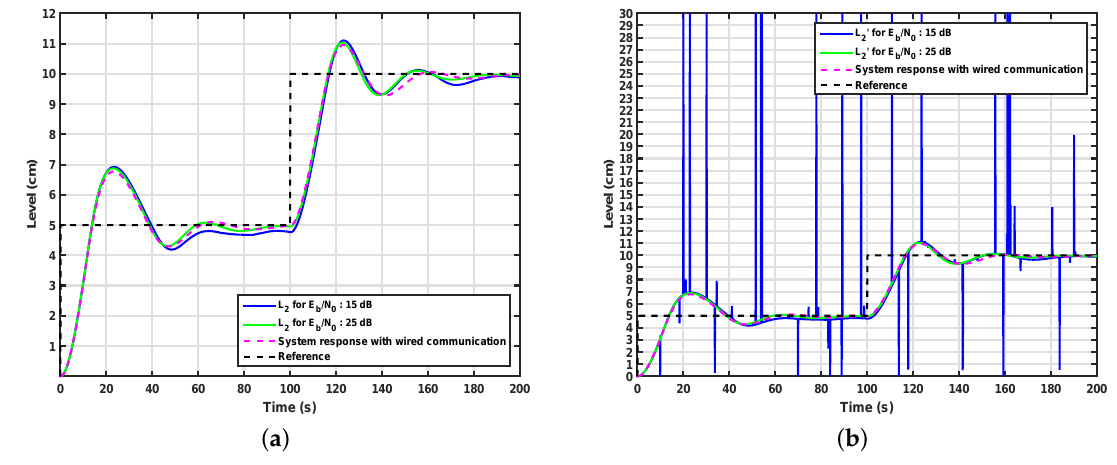
Figure 11. ( a ) System response with wavelet coding based on 2 × 32 WCM for k = 0.5; ( b ) signal received by the controller in a system with wavelet coding based on 2 × 32 WCM for k =